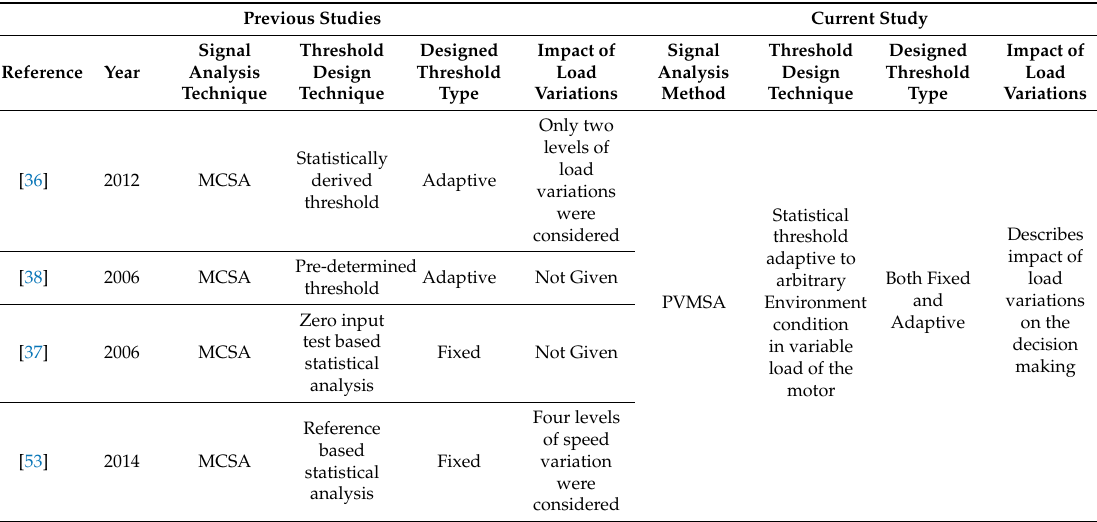
Table 6. The comparison of proposed fault diagnosis scheme with previous fault diagnosis schemes. Previous Studies Current